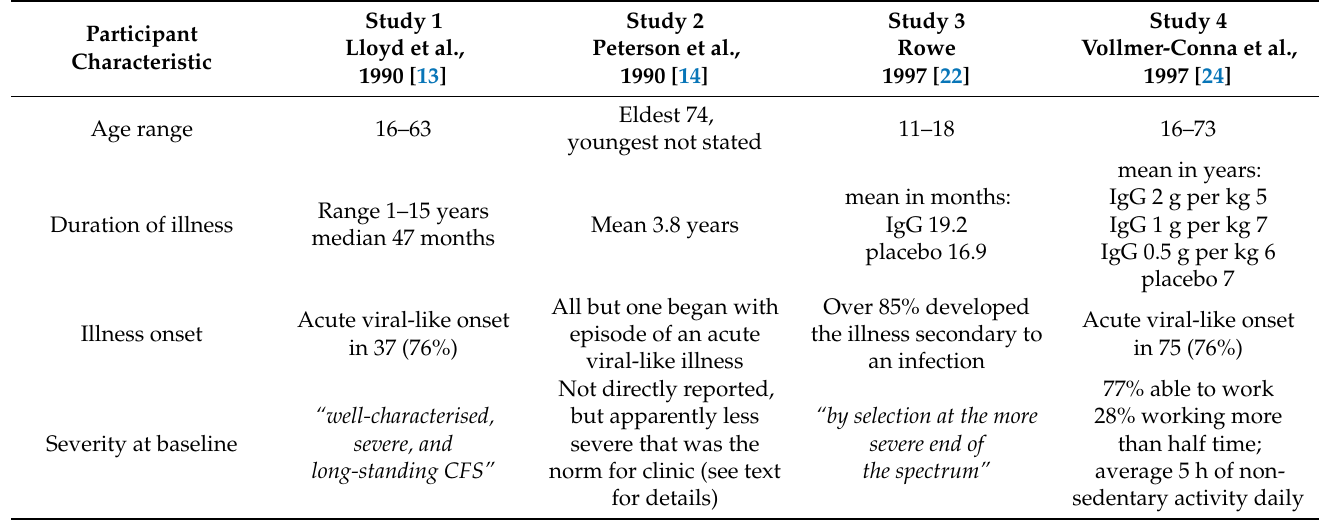
Table 2. IV immunoglobulin trial participant